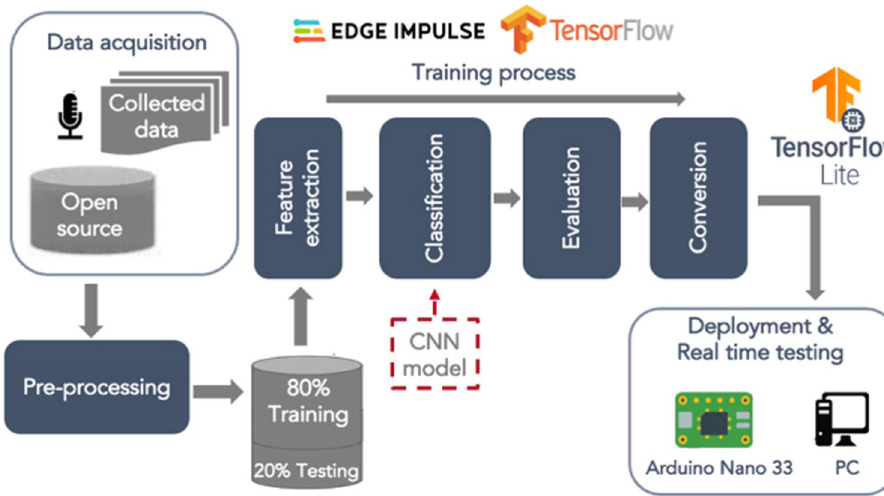
Fig. 2 LimitAcess ML pipeline starts with data collection and preprocessing the data before feeding them into the CNN model. After training the model, it is converted to Ten- sorFlowLite for deployment on an Arduino Nano